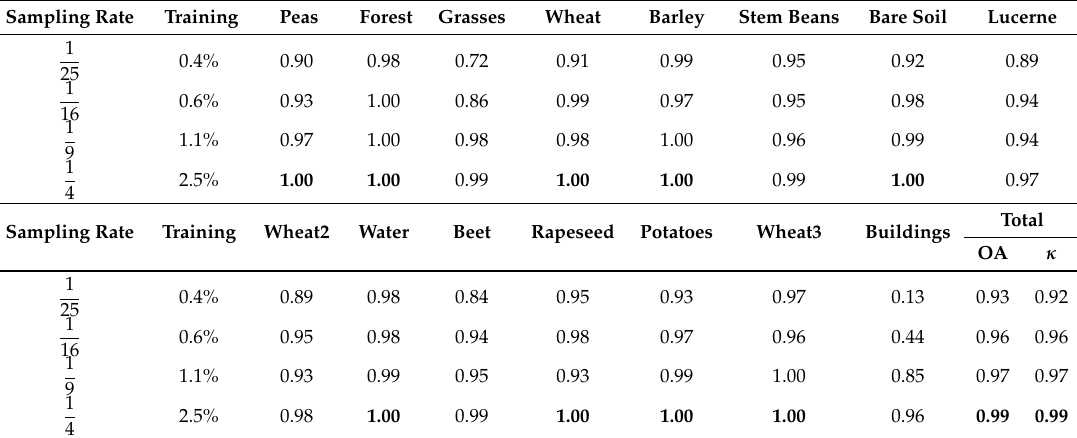
Table 2. Classification accuracy on dataset Flevoland for different sampling